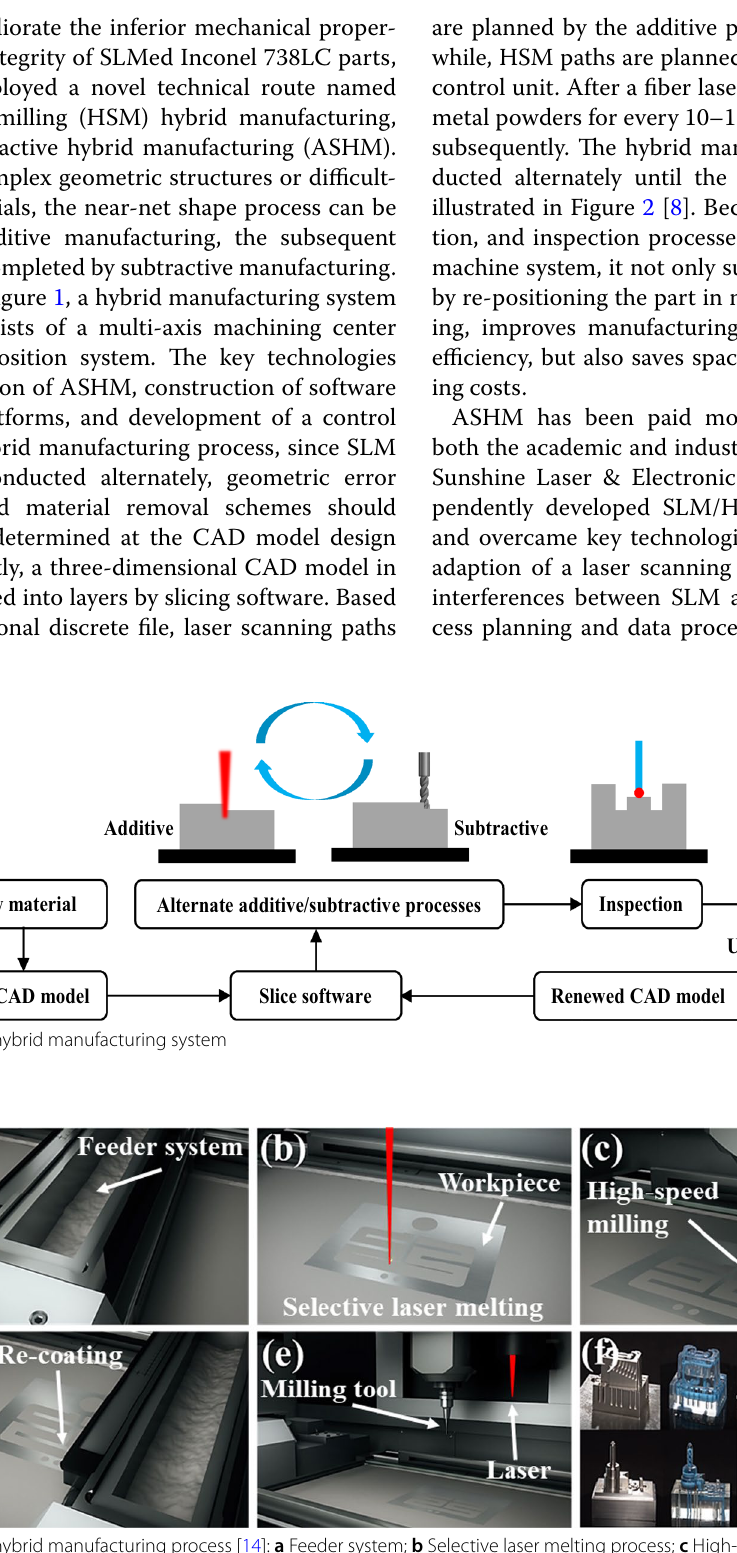
Figure 2 SLM/HSM hybrid manufacturing process [14]: a Feeder system; b Selective laser melting process; c High-speed milling process; d Re-coating; e SLM/HSM hybrid manufacturing; f Sample parts with complex inner passages and external